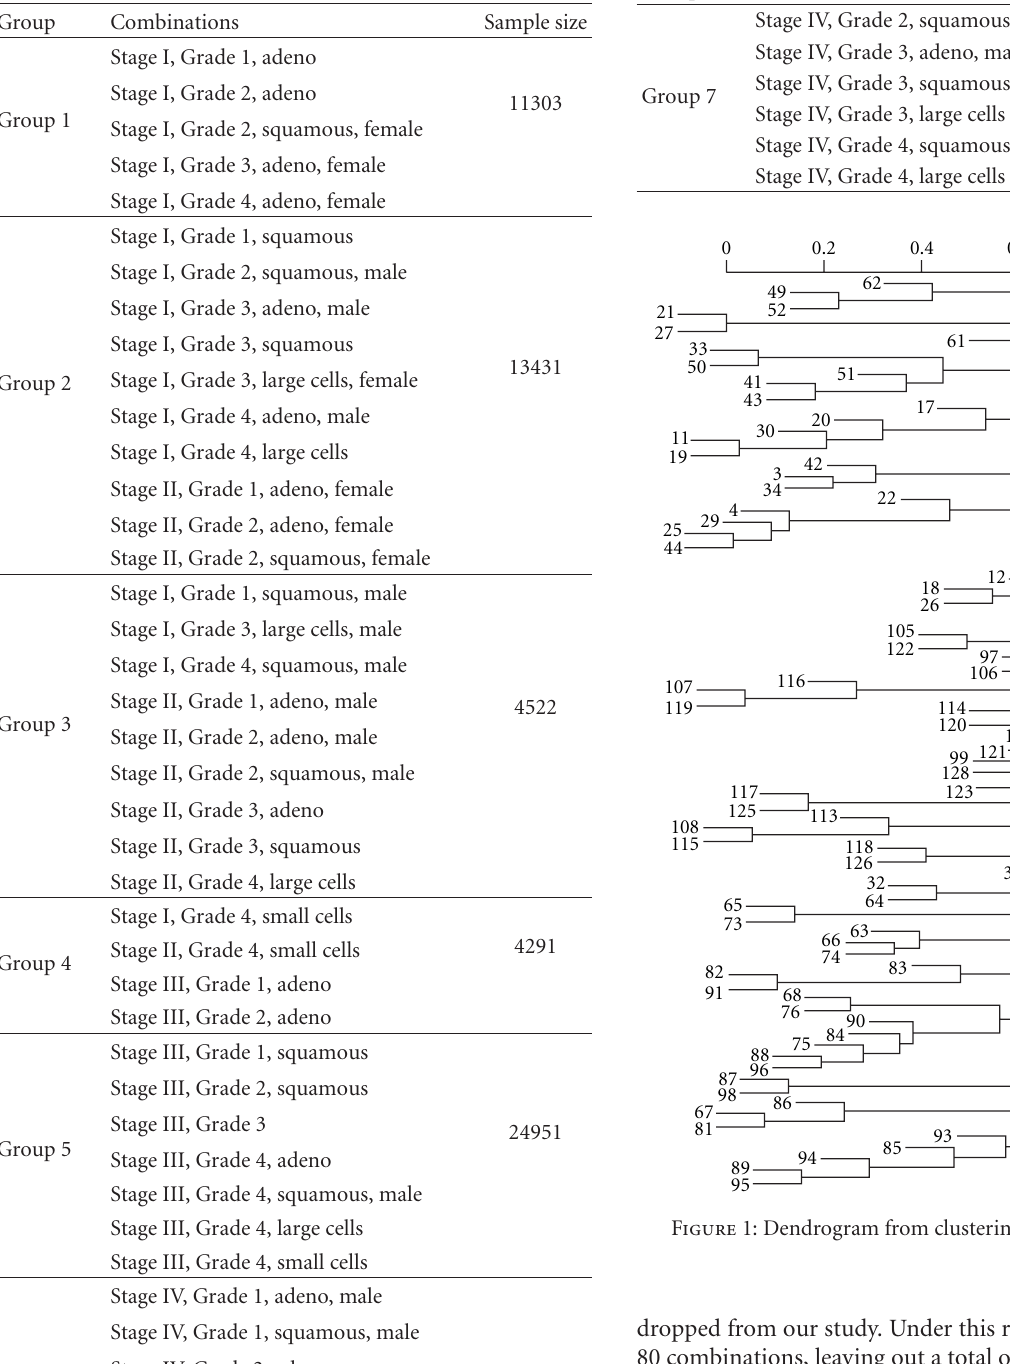
Table 3: Seven groups produced by cutting the dendrogram in Figure 1 at the height 0.93.